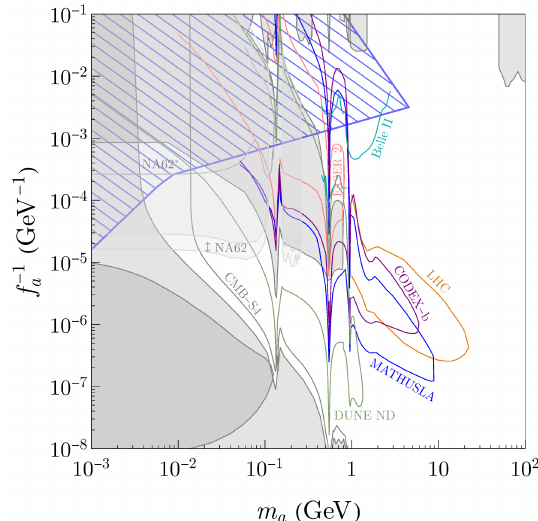
Figure 3 . The blue hatched region shows the viable parameter space where the baryon asymmetry can be explained by axiogenesis with a heavy QCD axion, specifically for the tuned case where parametric resonance occurs precisely during the electroweak phase